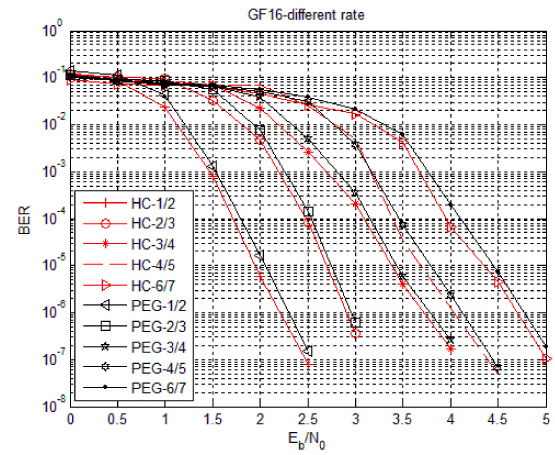
Figure 7. Bit Error Rate (BER) performance of HC algorithm under Code3.